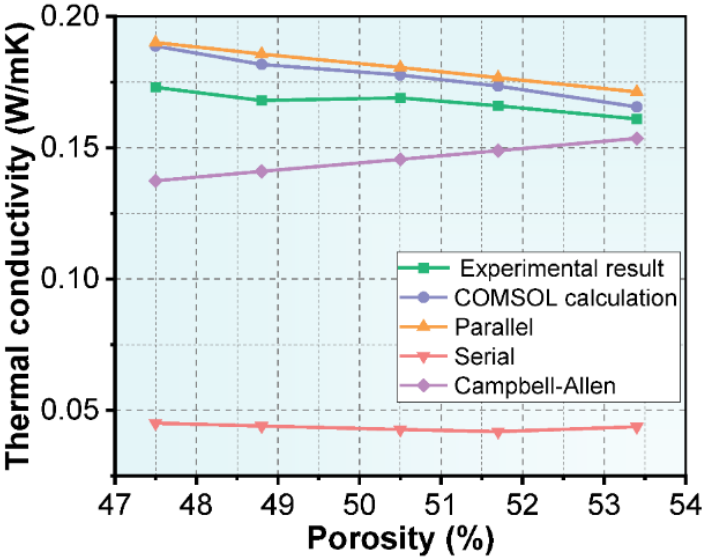
Figure 12. Comparison between COMSOL analysis, classical thermal conductivity models and test results. Table 6. Relative errors between the thermal conductivity of the COMSOL analysis, classical thermal conductivity models and test results.